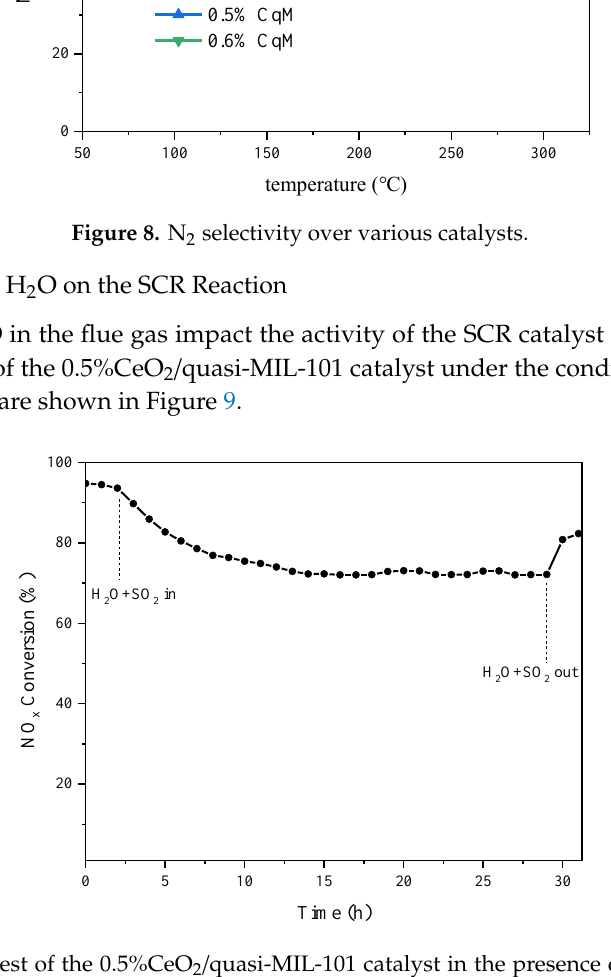
Figure 8. N 2 selectivity over various catalysts.